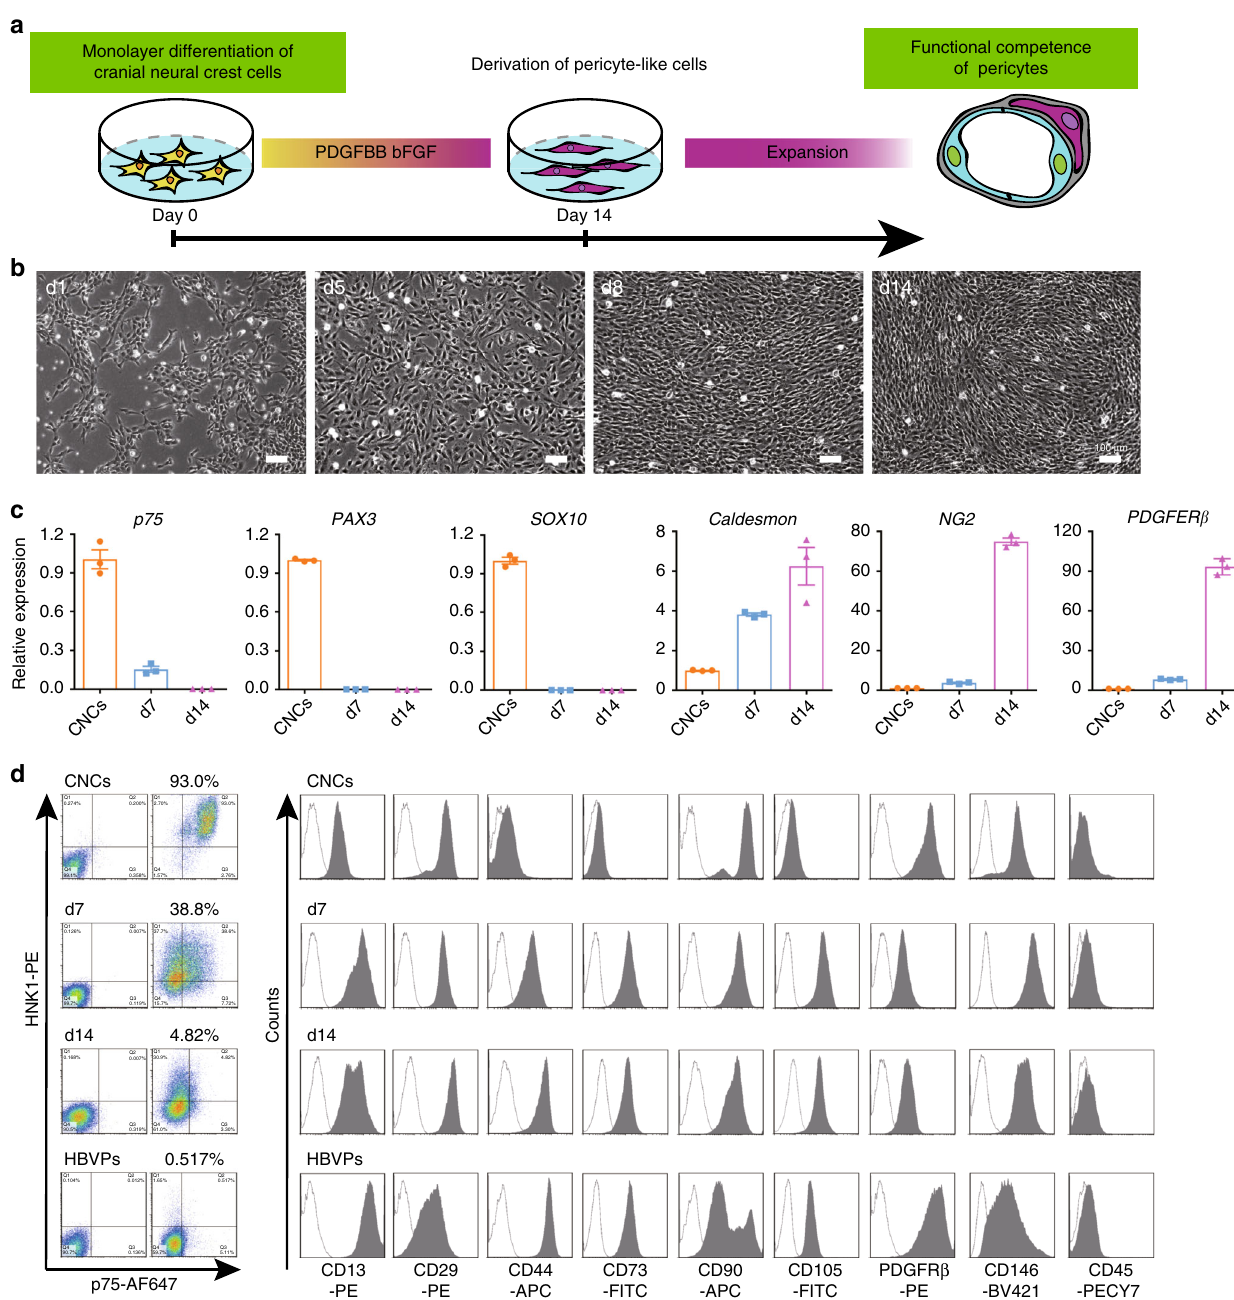
Fig. 2 Differentiation of hiPSC-derived CNCs to pericyte-like cells. a Strategy for deriving pericyte-like cells from hiPSC-derived CNCs. b The morphology change during pericyte differentiation from CNCs was detected under phase-contrast microscopy. Scale bar: 100 μ m. c qPCR were used for analyze the expression of CNC-speci fi c genes ( p75 , SOX10 , PAX3 ) and pericyte markers ( Caldesmon , NG2 , PDGFR β ) during differentiation of pericyte-like cells from CNCs. d . FACS analysis for the surface marker expression of hPSC-CNCs, hPSC-CNC PCs (day 7 and day 14), and HBVPs. Graphs represent the individual data points, the mean ± SEM of three independent experiments. FACS analysis and Bright fi eld images are representative of n = 3 biological replicates. Source data are provided as a Source Data fi